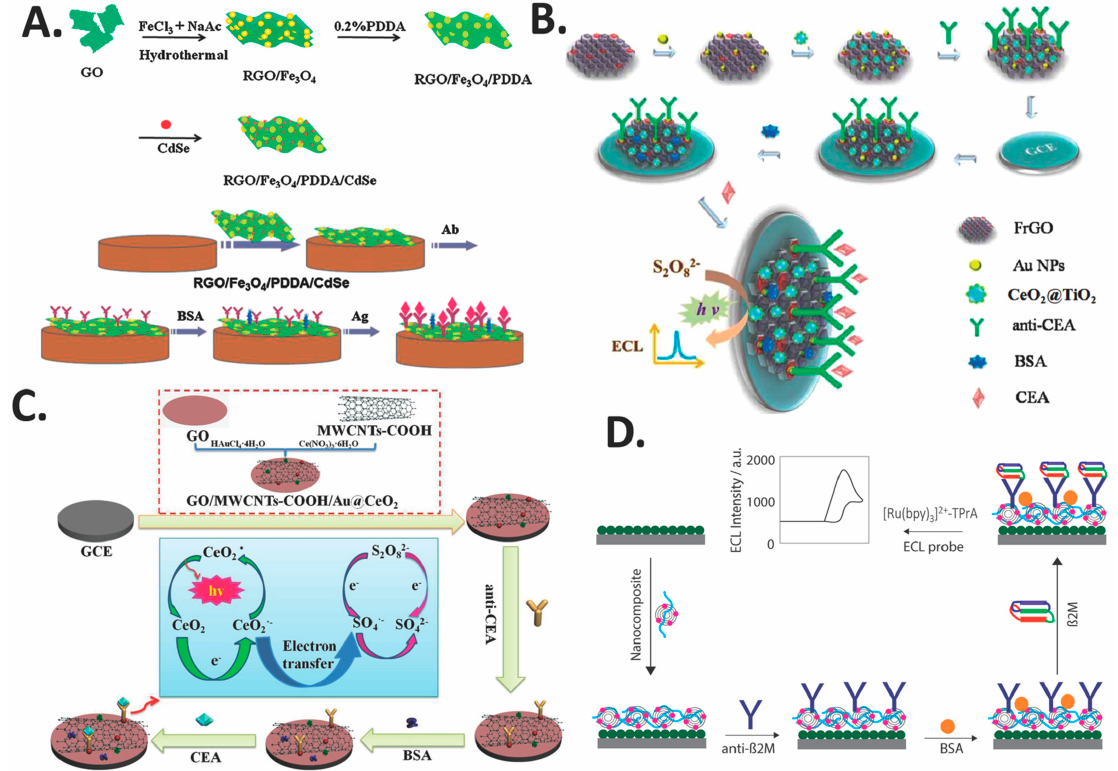
Figure Figure 10: Carbon nanocomposite-based ECL nanobiosensors: ( A ) ECL nanobiosensor with nanocomposite of Au-FrGO and CeO 2 @TiO 2 . Reprinted from Ref. [10] with permission from Elsevier; ( B ) ECL nanobiosensor with nanocomposite of (RGO)/Fe 3 O 4 /PDDA/CdSe. Reprinted from Ref. [9] with permission from Elsevier; ( C ) ECL nanobiosensor with nanocomposite of GO/MWCNTs-COOH/Au@CeO 2 . Reprinted from Ref. [68] with permission from the American Chemical Society; ( D ) ECL nanobiosensor with nanocomposite of AuNPs@CNOs-CS. Reprinted from Ref. [7] with permission from the Royal Society of Chemistry.